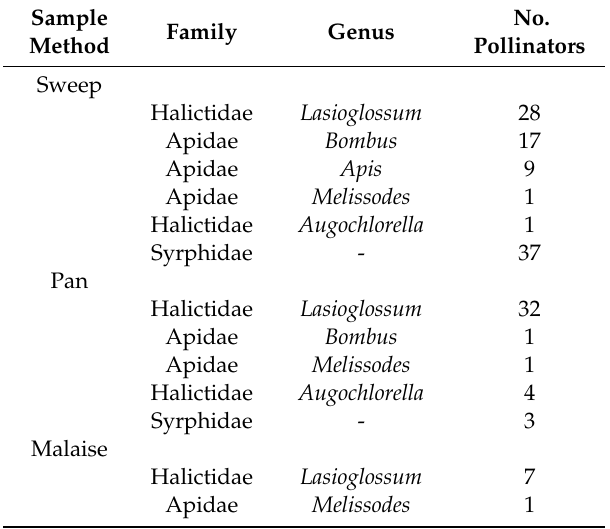
Table 2. The total number of pollinators collected using various methods.